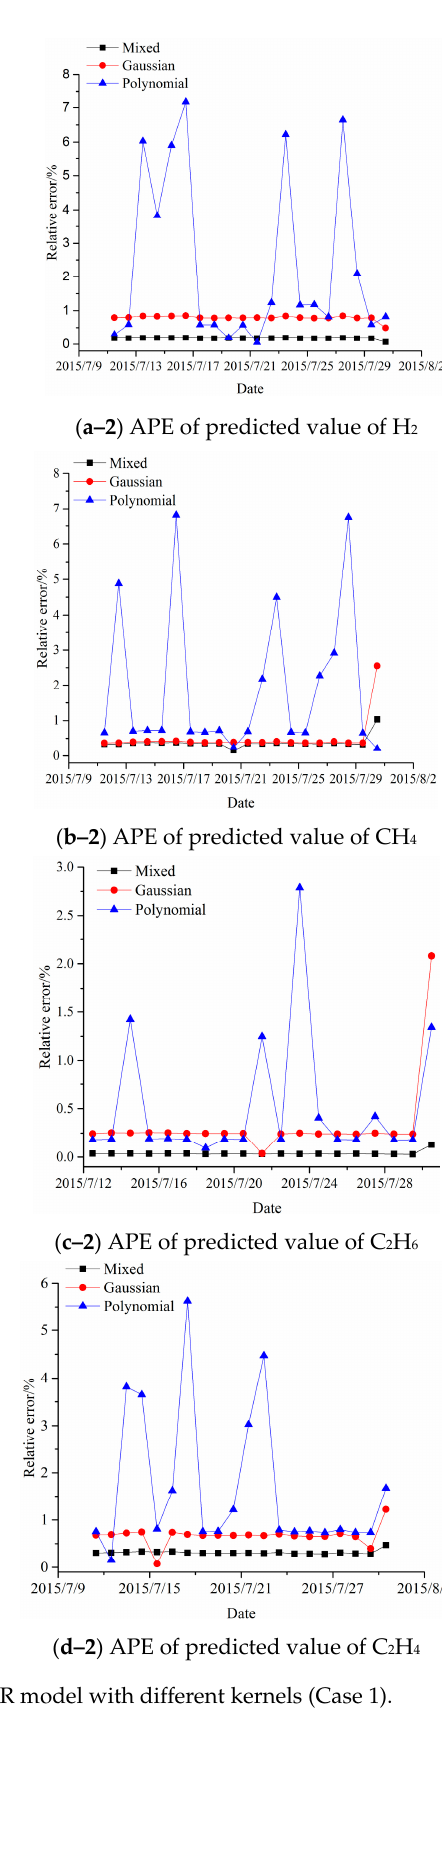
(18) Table 5. The optimal parameters of each dissolved gas sequence. Case No. Dissolved Gas